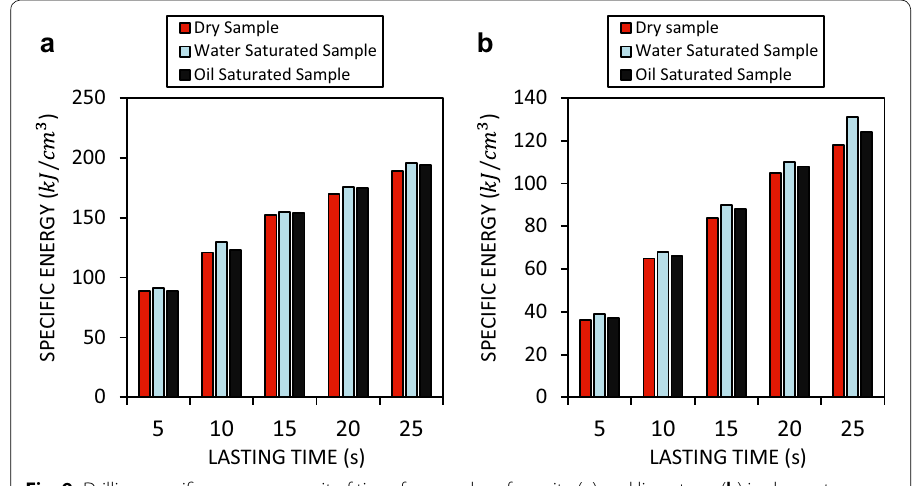
Fig. 9 Drilling specific energy per unit of time, for samples of granite ( a ) and limestone ( b ) in dry, water saturated and oil saturated conditions [12]